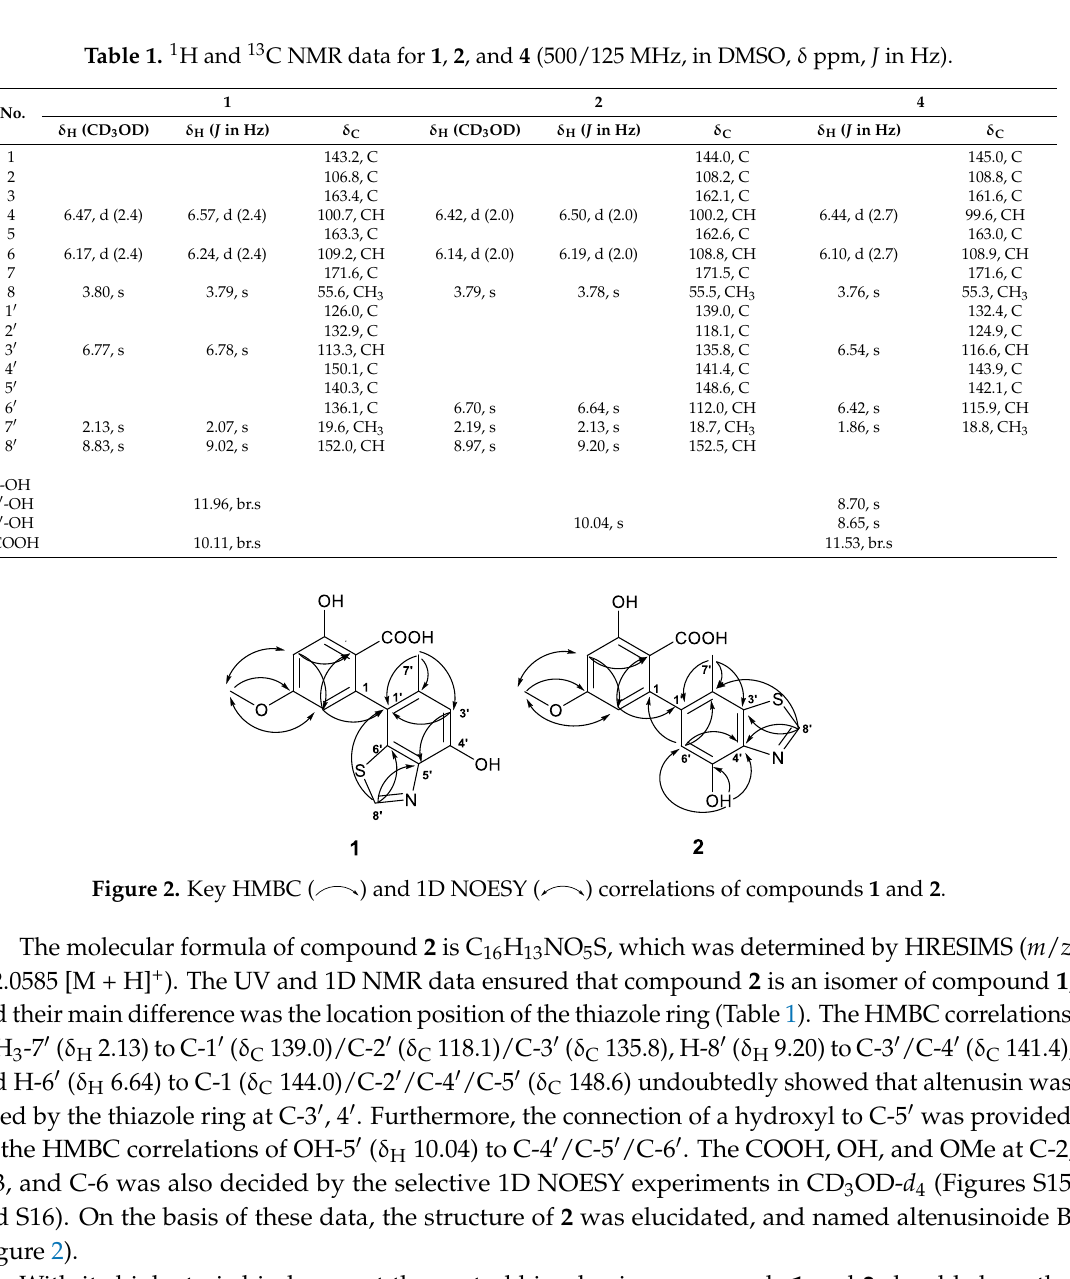
Table 1. 1 H and 13 C NMR data for 1 , 2 , and 4 (500/125 MHz, in DMSO, δ ppm, J in Hz).